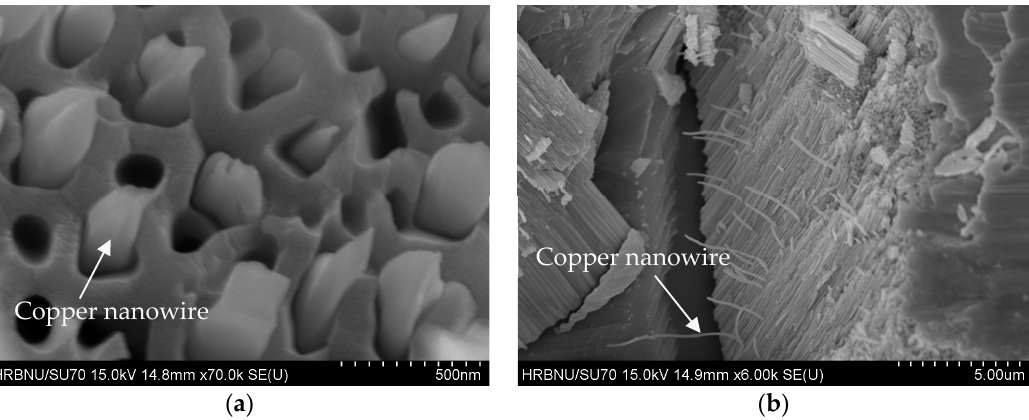
Figure 4. Electron microscopy photographs of composite alumina film filled with copper nanowires ( a ) Surface and ( b ) Cross.